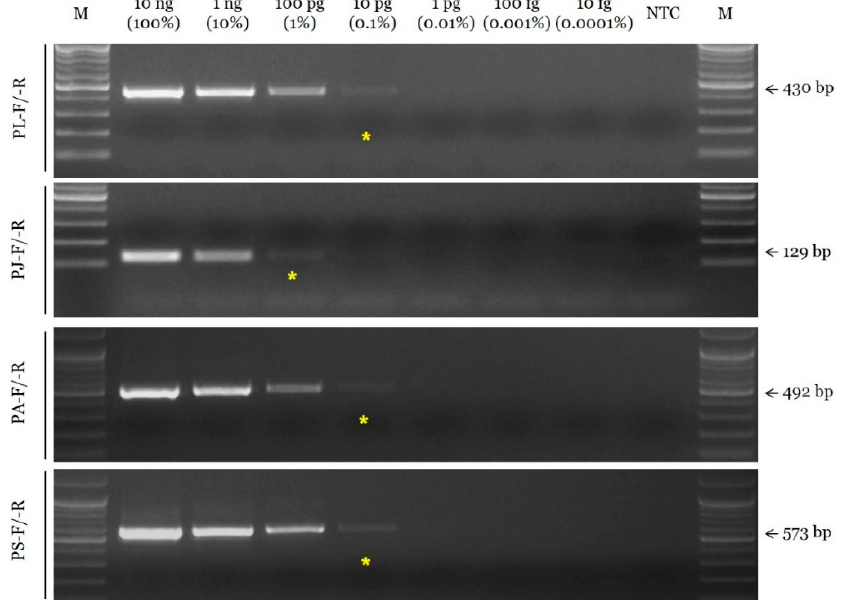
Figure 2. Assessment of the sensitivity of SCAR primers using the conventional PCR assay. Primer combinations (PL-F/-R, PJ-F/-R, PA-F/-R, and PS-F/-R) are indicated on the left. Arrows and numbers situated on the right indicate the amplicon size. M is the 100 bp DNA ladder. Yellow asterisks indicated the limit of detection (LOD).